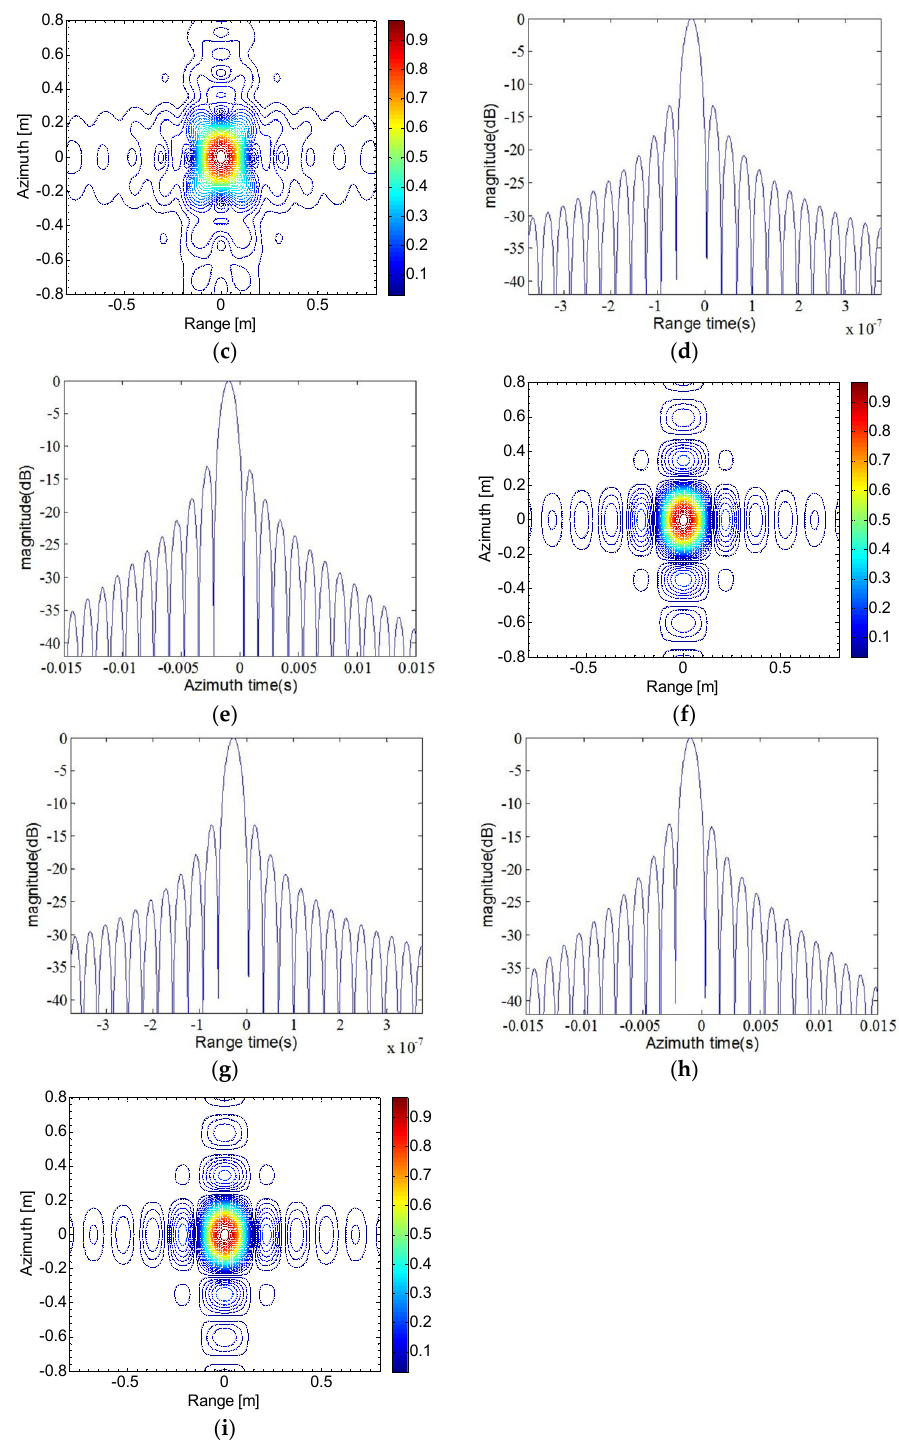
Figure 12. Imaging results of P 1 , the point at the swath center. ( a – c ) The range profile, the azimuth profile and the contour map achieved using the Deramping ω k algorithm based on the stop-go model; ( d – f ) The range profile, the azimuth profile and the contour map achieved using the algorithm based on the continuous rectilinear model; ( g – i ) The range profile, the azimuth profile and the contour map achieved using the novel imaging compensation method presented in this paper.